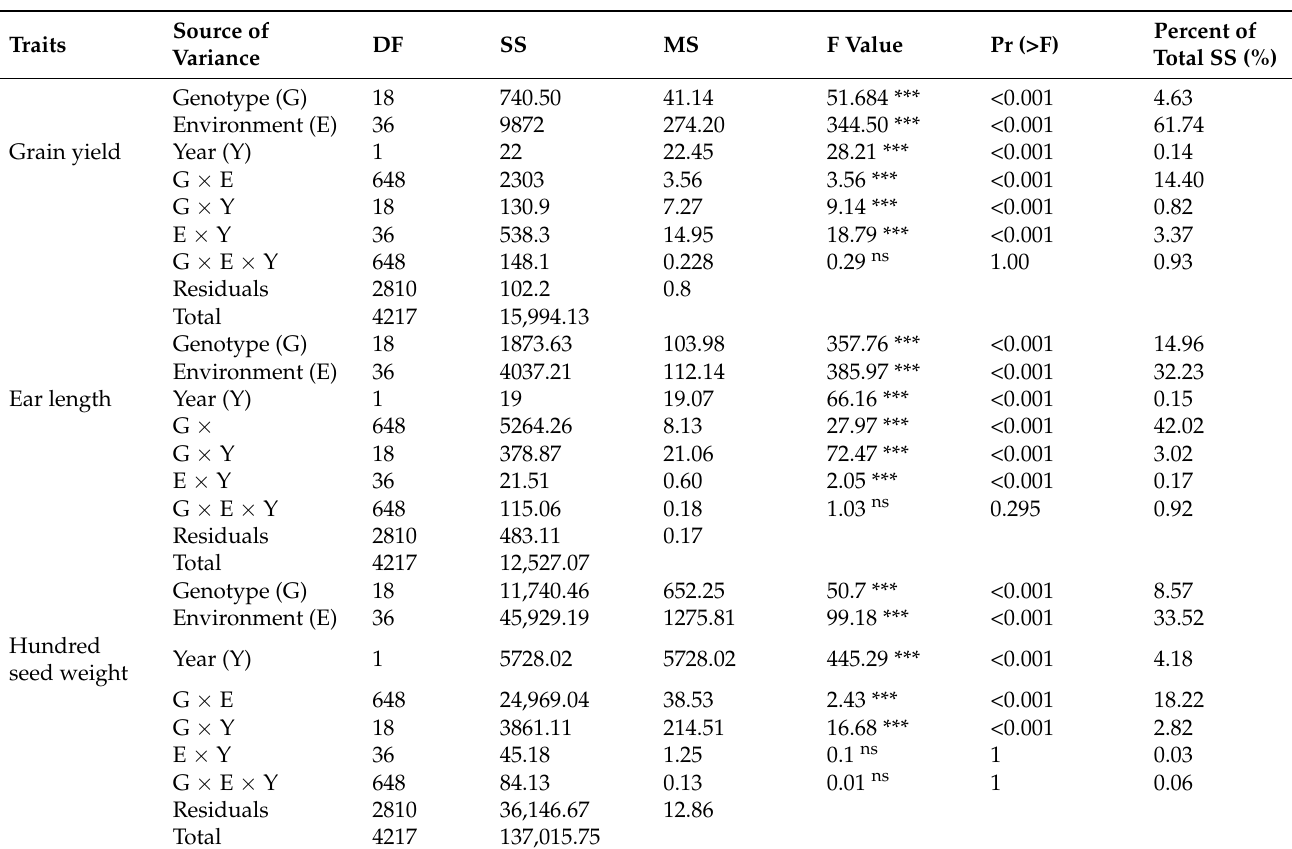
Table 2. The three-way analysis of variance for 19 maize genotypes for yield components during 2018 and